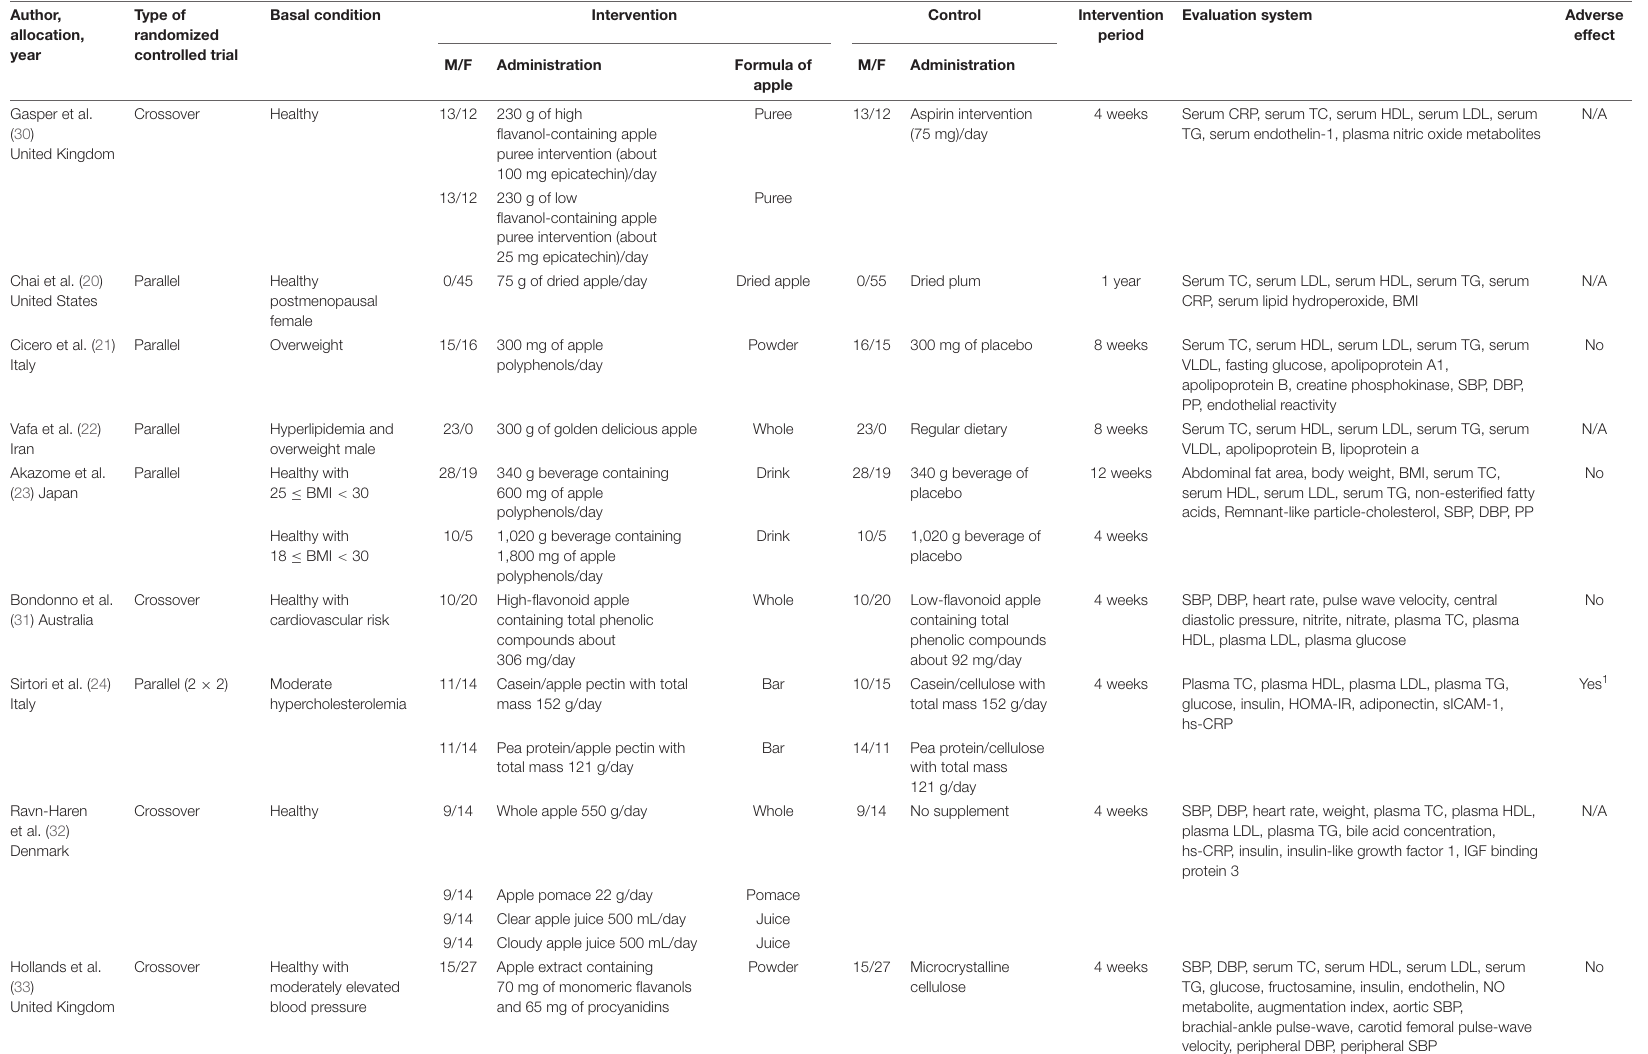
TABLE 3 | Summarized information of the studies which were incorporated into the